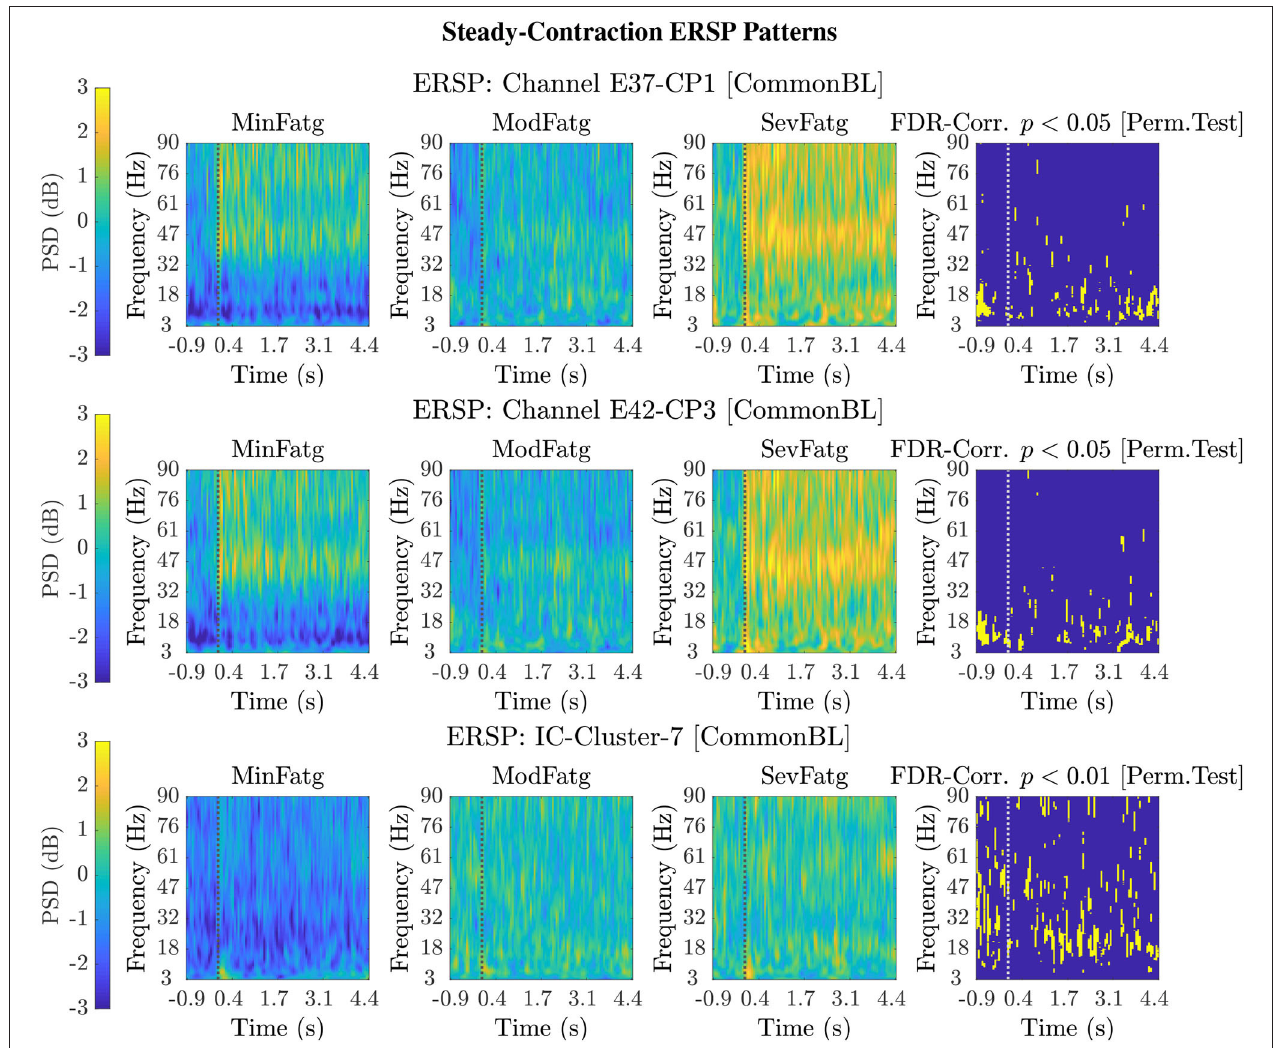
FIGURE 4 | Representative 2-D patterns ERSP FatgCond AVG generated for the EEG data recorded from two scalp electrodes, CP1 and CP3, during the steady contraction are depicted in the top and middle row, respectively. For the source-level analysis, the ICA decomposition was performed on the multichannel EEG signals and the IC clusters were estimated. The ERSP patterns are shown in the bottom row for IC Cluster 7 that comprises ICs located near the right paracentral lobule. Both the channel-level and source-level ERSP analyses reveal that the PSD computed in the theta, alpha, and beta frequency band scales with the fatigue level. The results from the permutation test followed by the FDR correction with a threshold p -value of 0.05 (except for IC Cluster 7 with p < 0.01) are displayed in the last column in every row. The dotted vertical line in each ERSP pattern denotes the onset of the elbow flexion